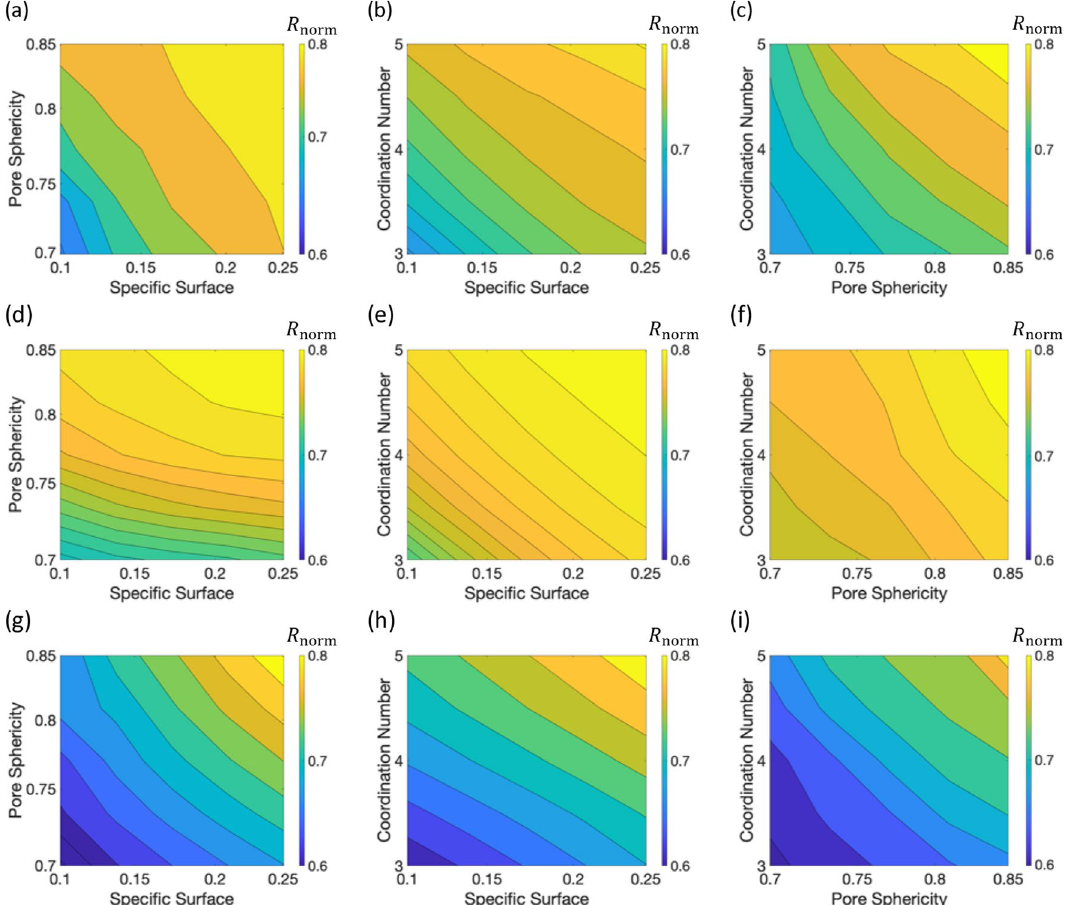
Figure 6. The effect of specific surface, pore sphericity and coordination number on normalized effective reaction rates ( R norm ) under different Pe and Da conditions: ( a–c ) at Pe = 0.1, Da = 0.3, Da II = 0.03; ( d–f ) at Pe = 1, Da = 0.03, Da II = 0.03; ( g–i ) at Pe = 0.1, Da = 2.7, Da II = 0.27. The values of coordination number (4.6) in the left column, pore sphericity (0.76) in the middle column, and specific surface (0.13) in the right column are fixed to their average values in the